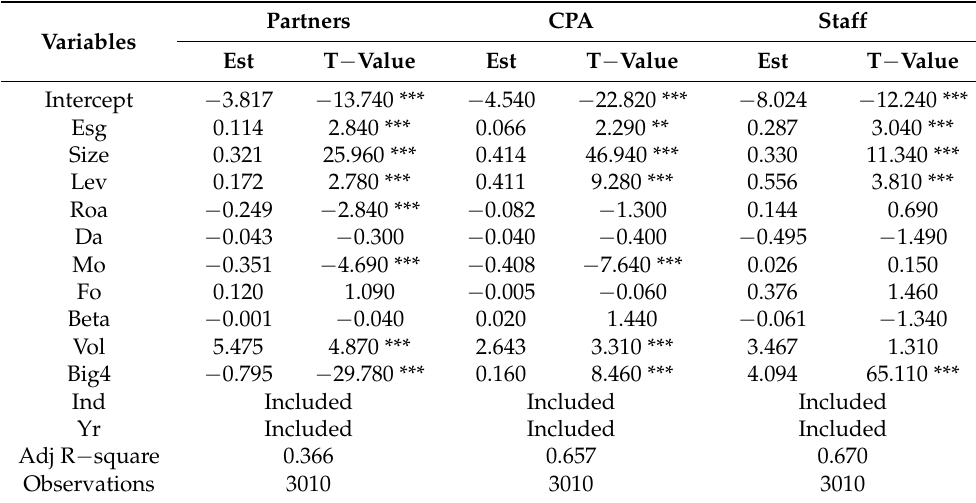
Table 6. The relationship between ESG and audit hours by rank. Variables